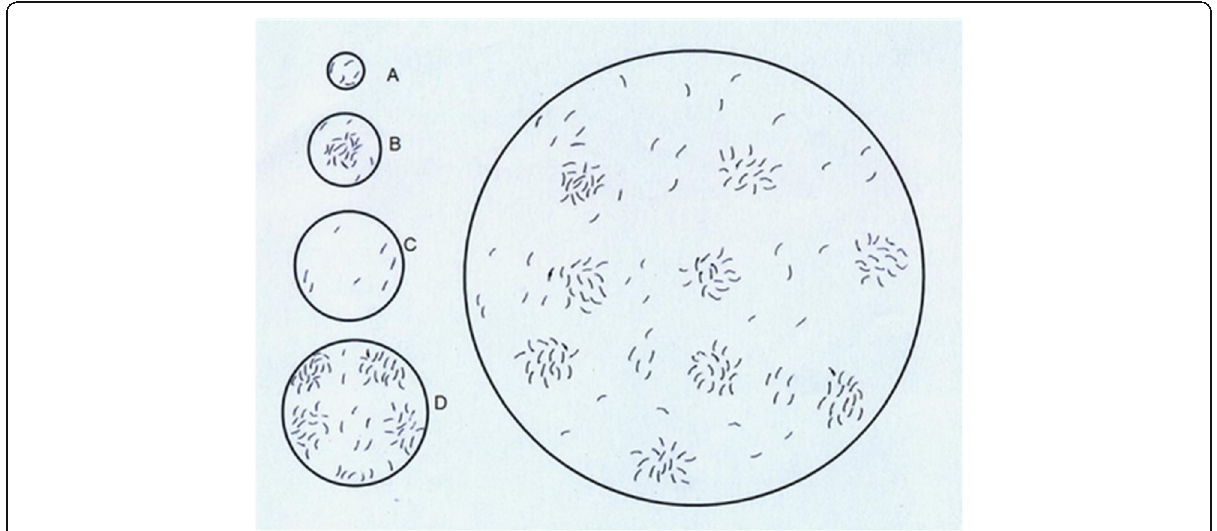
Fig. 3 Four quadrat sizes ( a – d ) with different distribution pattern though taken from the largest sample size which represents a contagious distribution with regularly distributed clumps of nematodes (Abd-Elgawad